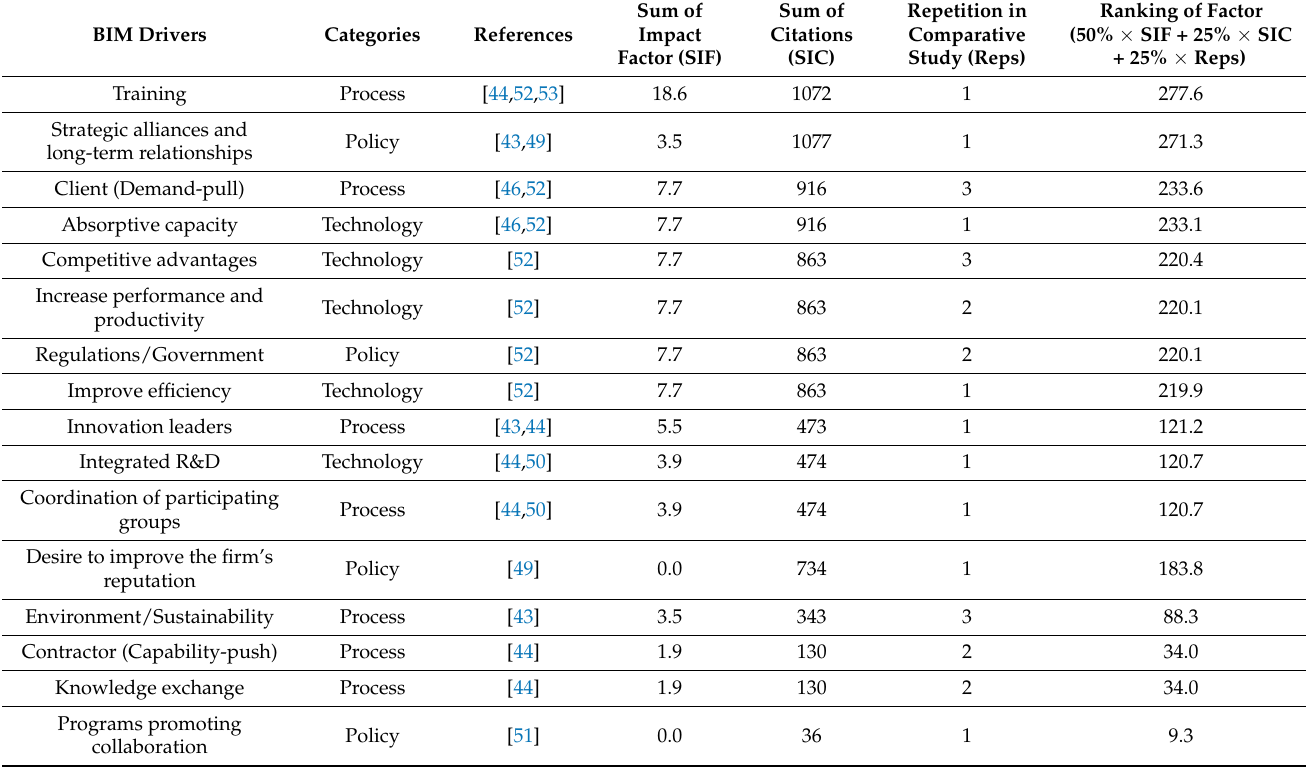
Table 8. Scores and ranks of BIM innovation drivers in developing countries.